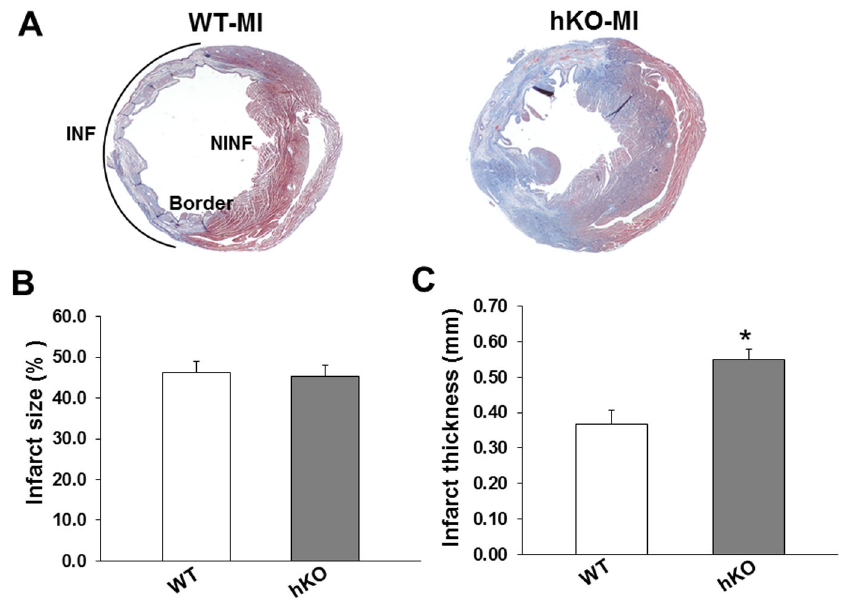
Figure 1. Infarct size and thickness. Masson’s trichrome stained sections from WT and hKO hearts were analyzed for the measurement of infarct size and thickness. A. Transverse sections of the mid-myocardium from WT and hKO hearts post-MI. Quantitative analysis of infarct size (B) and thickness (C) as measured from trichrome stained hearts; *p<0.05 vs WT; n=5-7. doi: